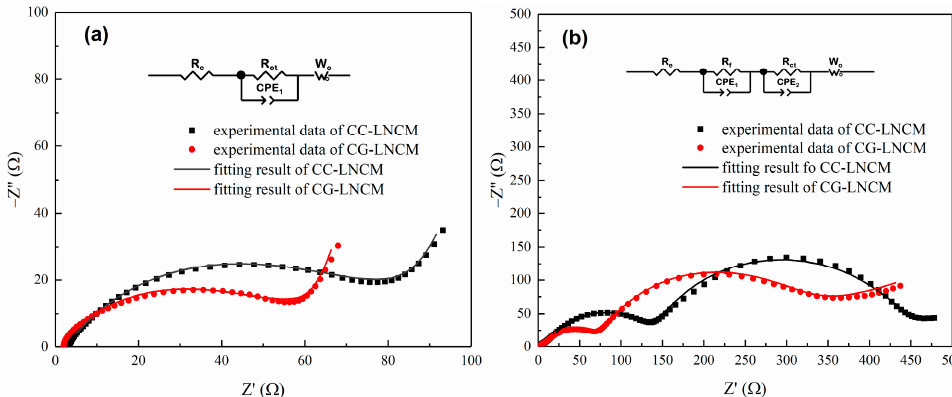
Figure 7. Nyquist plots of ( a ) fresh electrodes and ( b ) electrodes after cycling for 100 cycles at 5C.